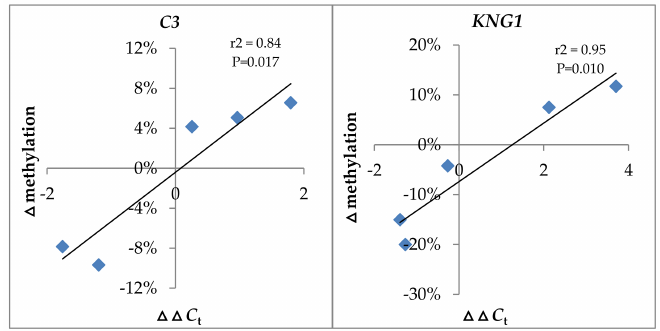
Figure 7. Correlation analysis between gene expression and DNA methylation levels of C3 and KNG1 after GCRV infection. The ∆∆ C t value was used to evaluate gene expression levels whereas the ∆ methylation between the infected and control groups was used to assess the DNA methylation